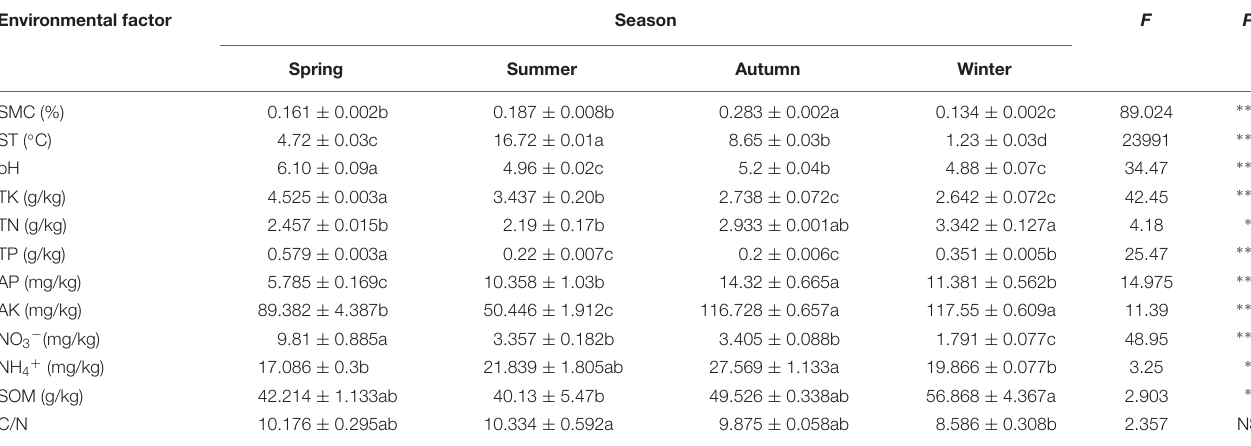
TABLE 1 | Environment factors of sampling